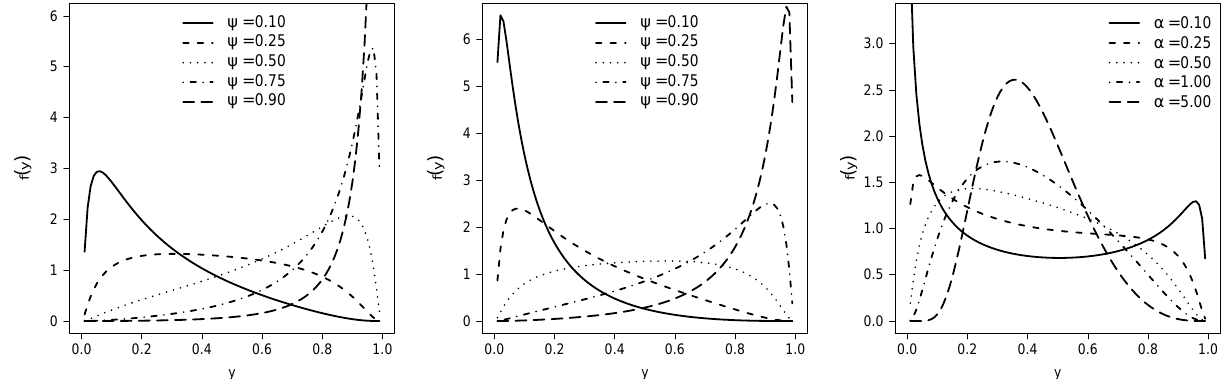
Figure 1. Pdf for RPGJSB1 q ( ψ , δ = 1, α ) model with logit link and G = Φ . Left panel: q = 0.25, α = 0.5, and varying ψ ; center panel: q = 0.5, α = 0.5, and varying ψ ; right panel: q = 0.5, ψ = 0.4, and varying α